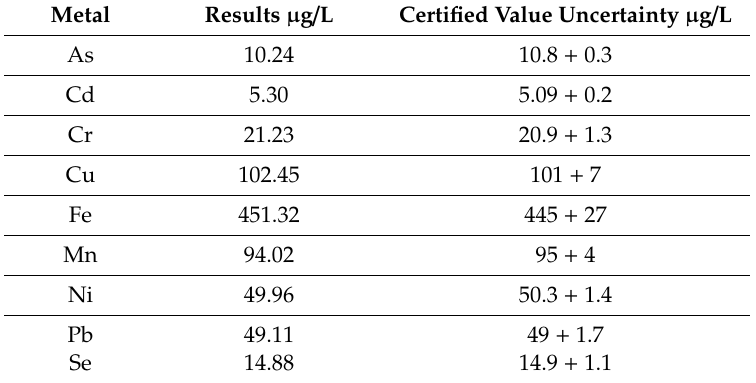
Table 1. Description of an internal standard used for ICP-MS analysis (CRM: ERM-CA713 Wastewater). Metal Results µ g /